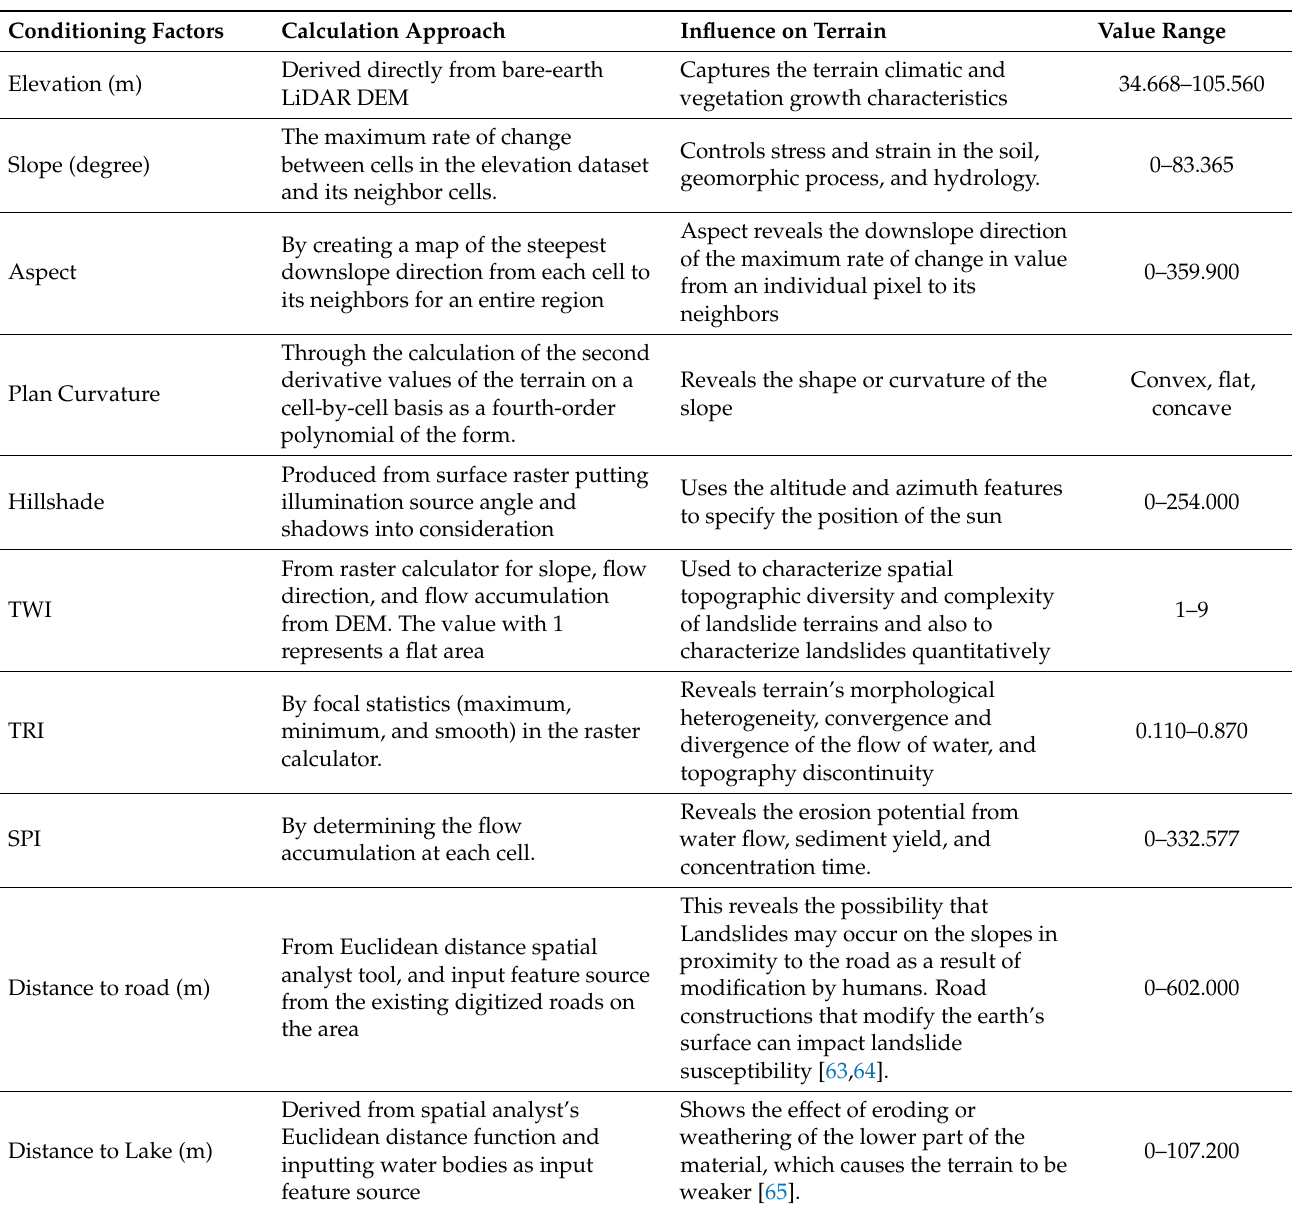
Table 1. Summary of the landslide conditioning